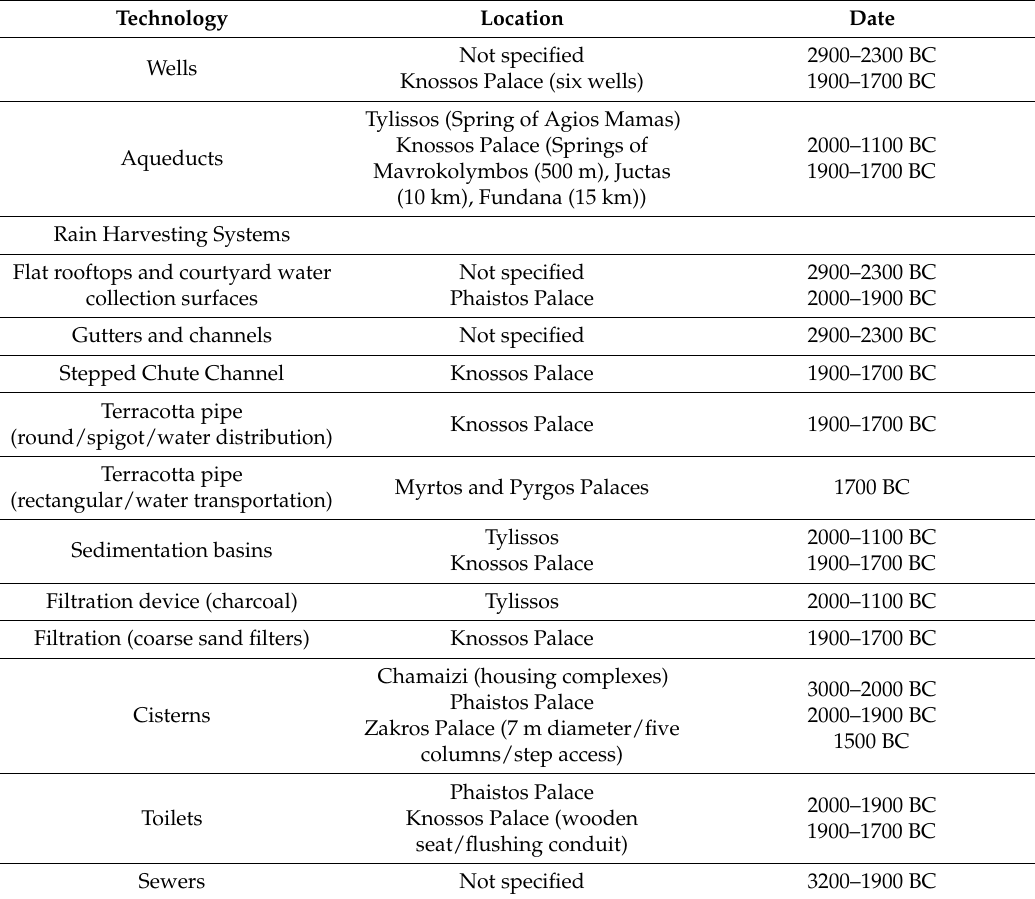
Table 1. Water technology developments of Ancient Minoa